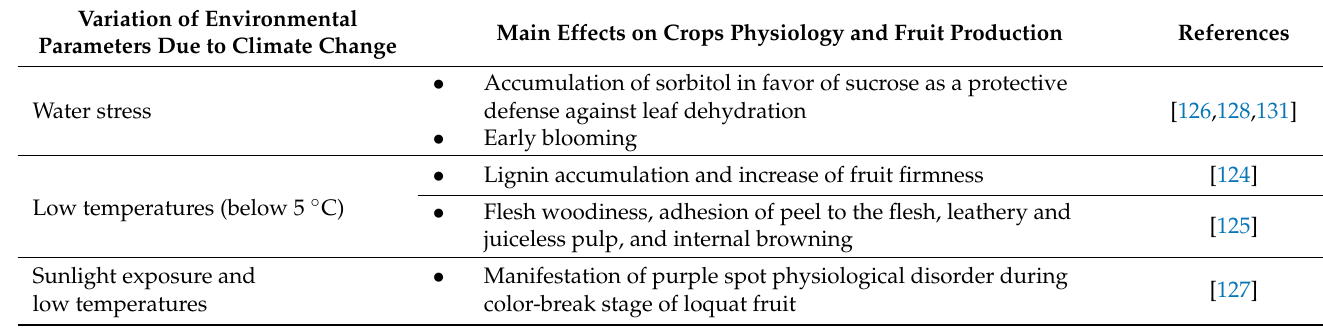
Table 3. Summary of principal effects of environmental conditions variation on Loquat.